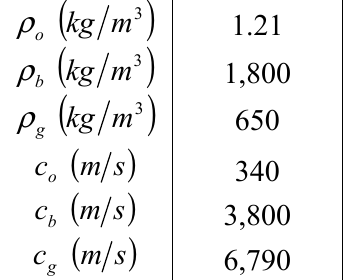
Table 1. Values of density and velocity for air (